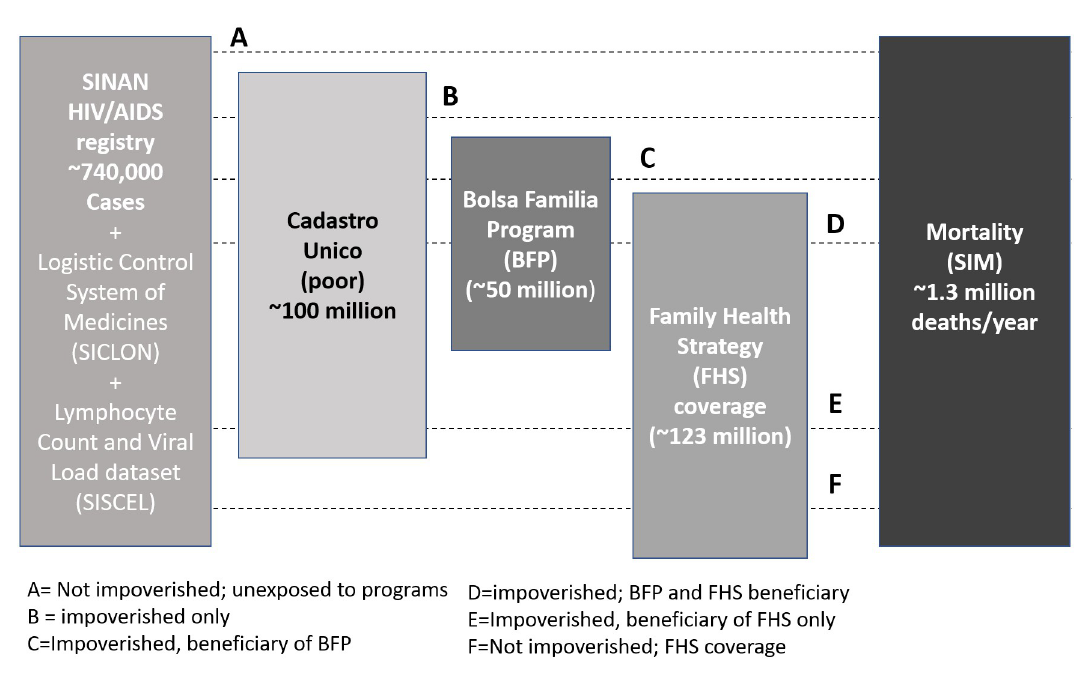
Fig 2. Datasets for linkage and subsequent study